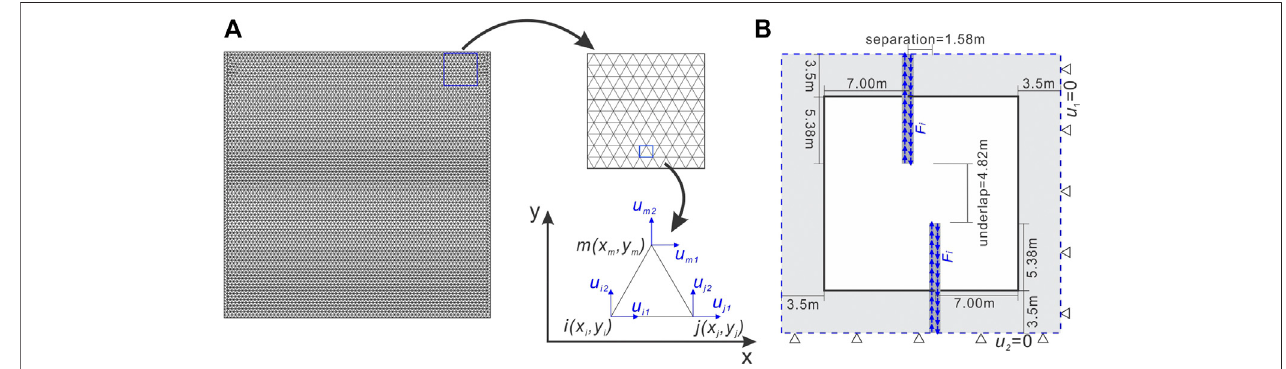
FIGURE 4| (A) The discretization results ofthe numerical model. The fi nite elements are the equilateral triangles except those near the boundaries. Each node has two dimensions of displacements ( u 1 and u 2 ). (B) The model is set up with two fault segments. The results bounded by the black box are shown in Figure 9 . The area marked in grey color is set to eliminate the boundary effect.